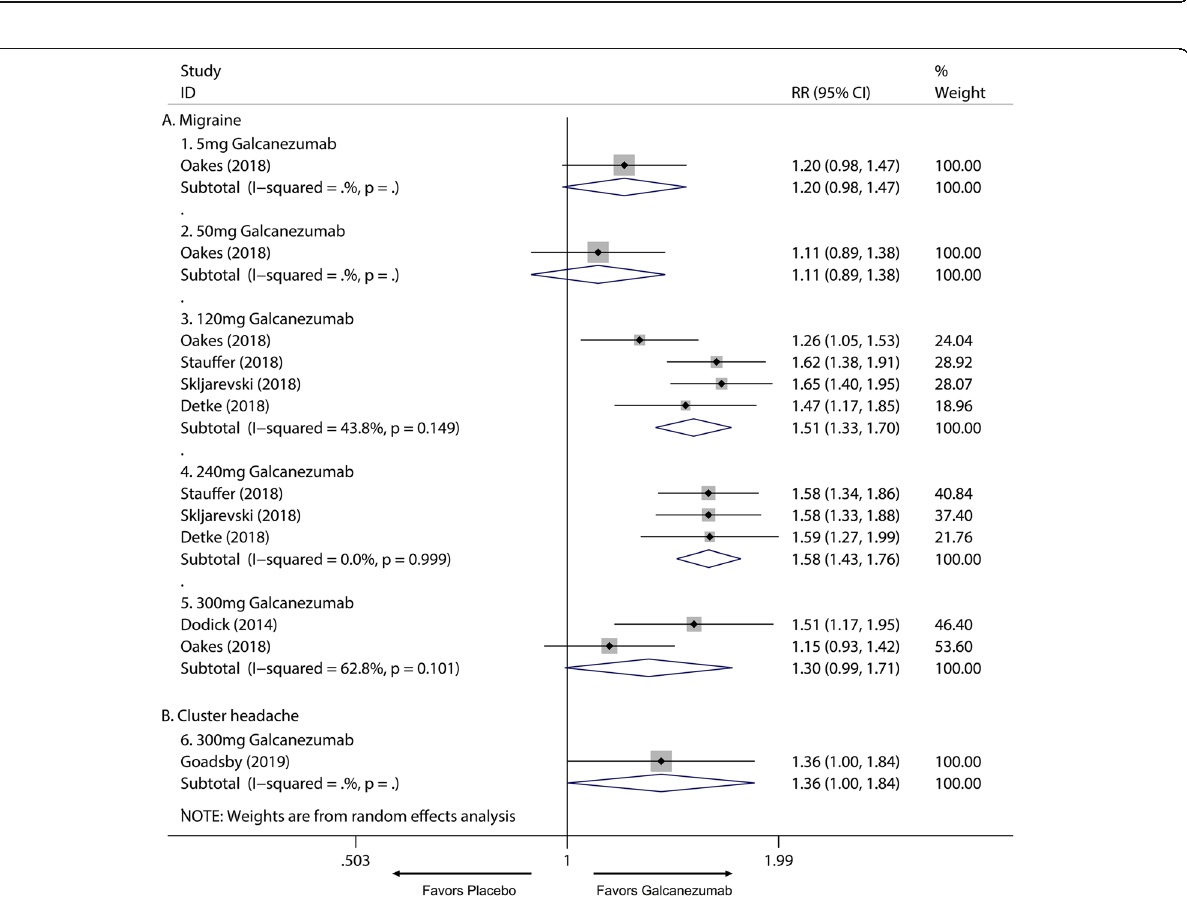
Fig. 3 The pooled relative risk of the 50% response rate (defined as at least 50% reduction of headache attack frequency from baseline) in different treatment doses compared with placebo, the diamond indicates the estimated relative risk with 95% confidence interval for the pooled patients. RR relative